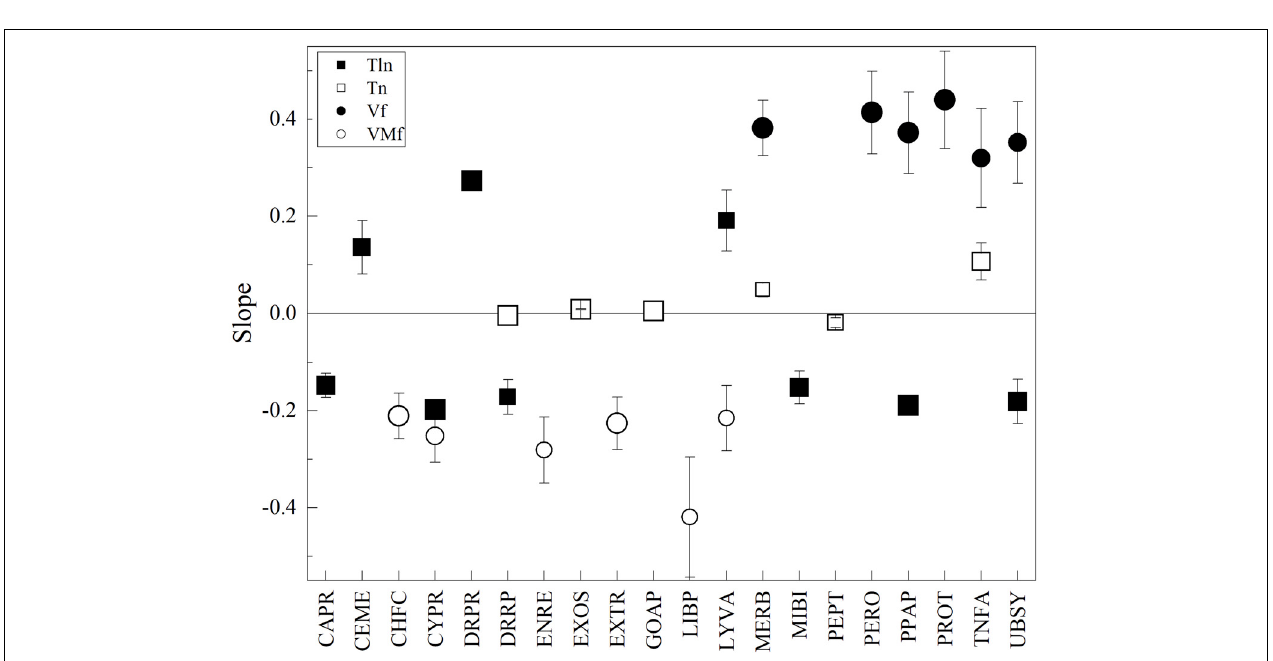
FIGURE 4 | Relationships between amino acid parameters and optimal temperature for the growth of Antarctic yeasts. The difference between yeasts in parameters by CDS groups (indicated in the X -axis) were plotted vs. their difference in optimal temperature for growth, and linear regression was applied. The slopes from regressions with R 2 ≥ 0.7 are shown. The size of the symbol represents R 2 from 0.7 to